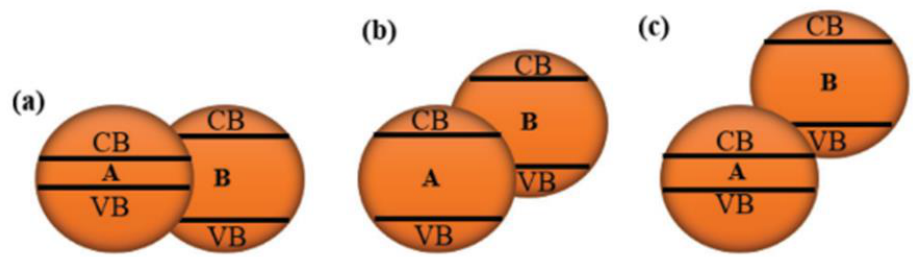
Figure 7. Band alignment of heterostructures ( a ) Type I, ( b ) Type II, and ( c ) Type III. (Reprinted with permission from Ref. [127]. 2017 John Wiley and Sons). permission from Ref. [127]. 2017 John Wiley and